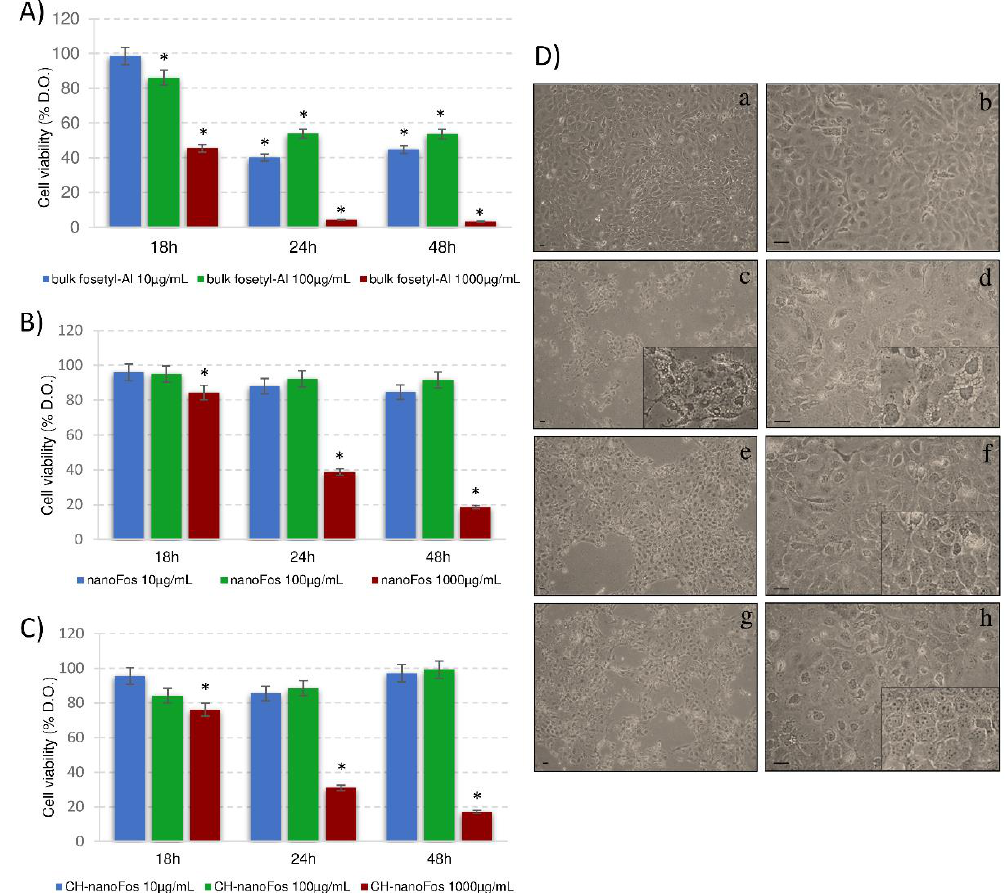
Figure 4. ( A ), ( B ), ( C ), 3-(4,5-dimethylthiazol-2-yl)-2,5-diphenyltetrazolium bromide salt (MTT) assay of ( A ) bulk fosetyl-Al; ( B ) nanoFos; ( C ) CH-nanoFos. The viability measured as indicated in the Methods section represents the values as percentage of the respective control (untreated cells) ones